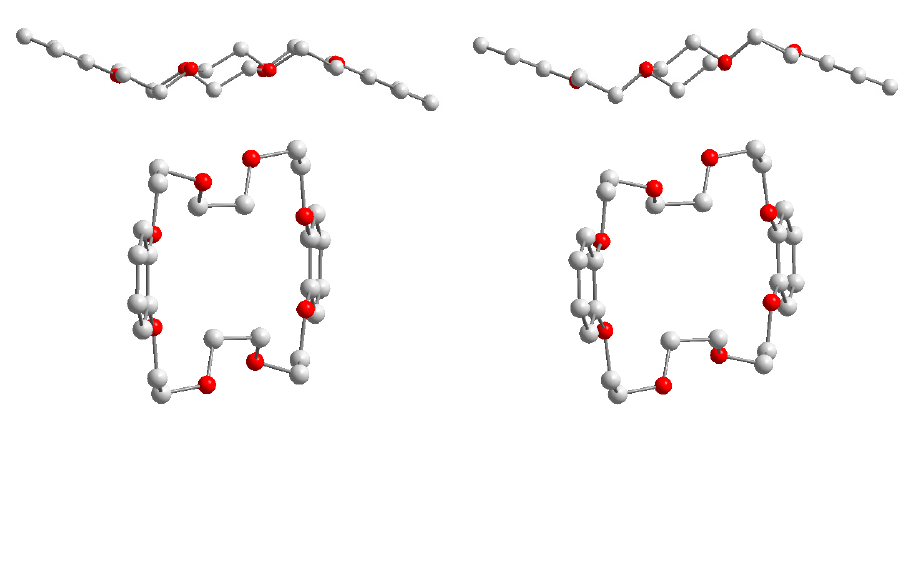
Figure 3. Comparison of the molecular structures of db24c8 molecules in the crystal )@(db24c8) (left) and (db24c8) structures of (I 2